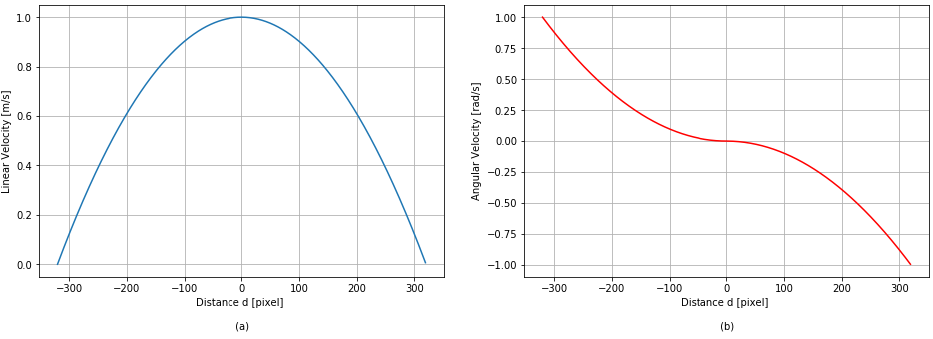
Figure 3. Considering a frame resolution of 640 × 480, a maximum linear velocity of 1 m/s and a maximum angular velocity of 1 rad/s the plot of the linear velocity control function is shown in Figure 2a, whereas, the plot of the angular velocity control function is shown in Figure